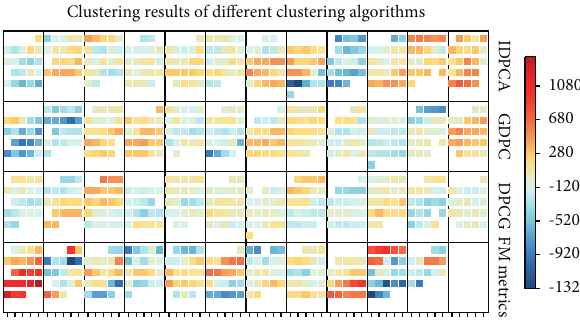
Figure 6: Clustering results of different clustering